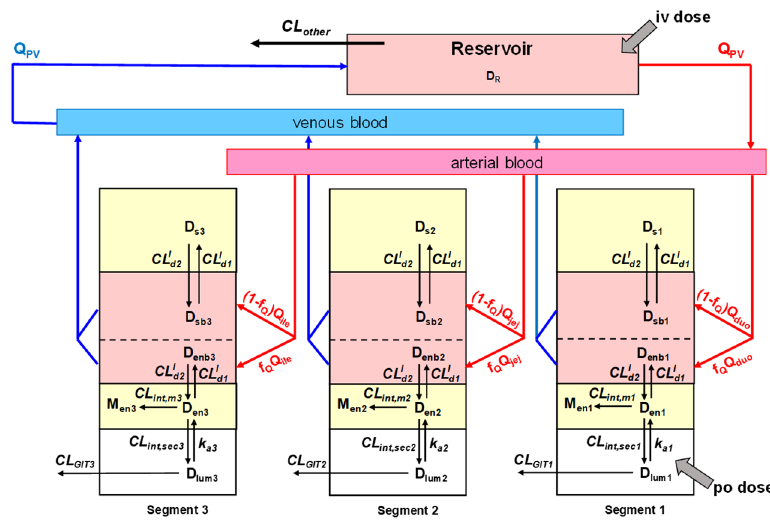
Figure 7. An expanded intestinal flow model—the segmental segregated flow PBPK model depicting the intestine as three different segmental regions with segregated flows to the enterocyte and serosal subcompartments. This figure was reproduced with permission from [121], ASPET, 2003.